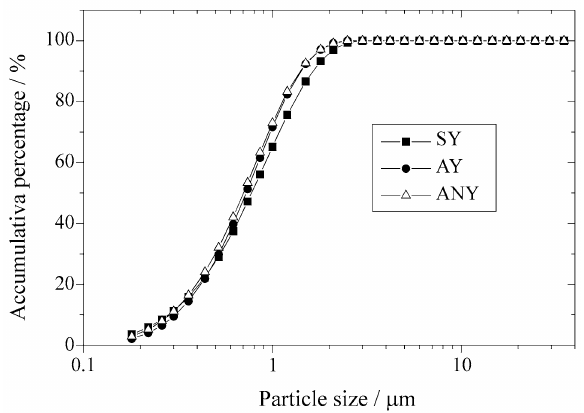
Figure 1. Particle size distribution of the powder